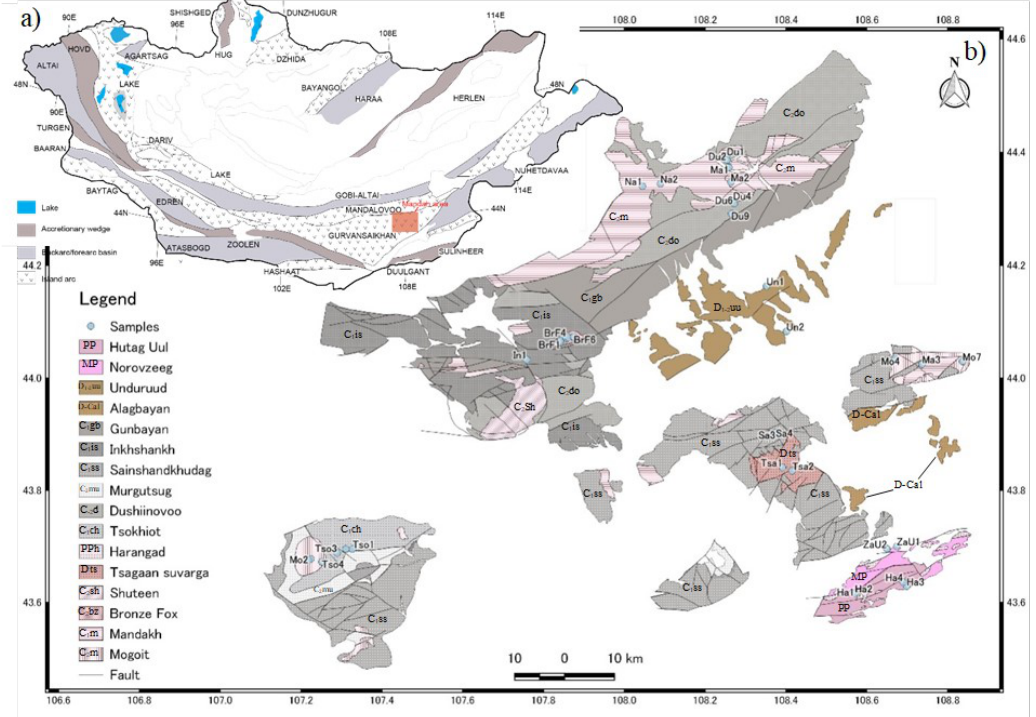
Figure 2. a. Modified terrane map of island arcs, related basins and accretionary wedge in Mongolia (Badarch, 2005), b. Distribution of magmatic rocks in Mandakh